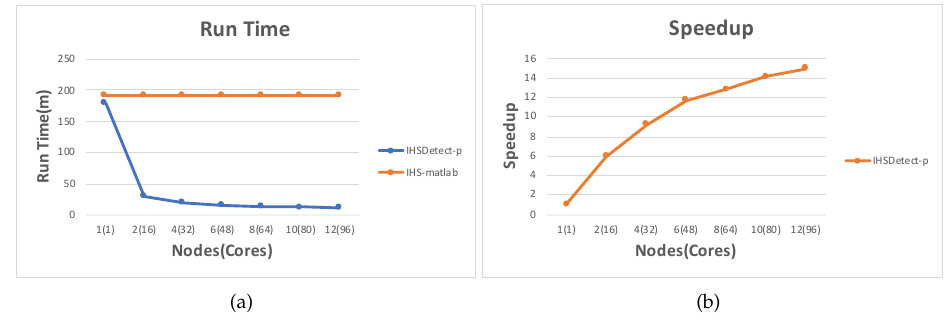
Figure 14. Comparative experimental performance analysis with increasing nodes (( a ) is for the run time merit of the performance, and ( b ) is fo the speedup merit of the